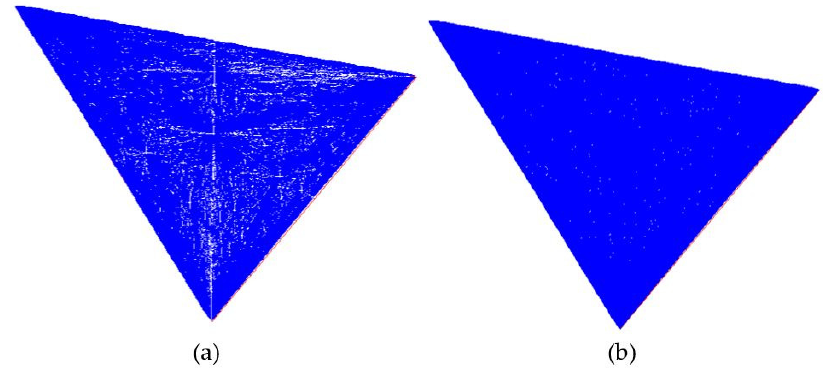
Figure 4. ( a ) The triangle filling results; ( b ) the improved triangle filling results.